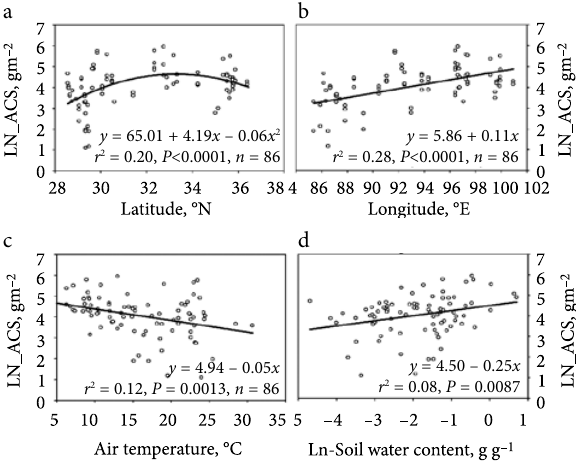
Fig. 1. Relationships between log-transformed above-ground carbon stock (ACS) and environmental variables: (a) latitude; (b) longitude; (c) air temperature; (d) soil